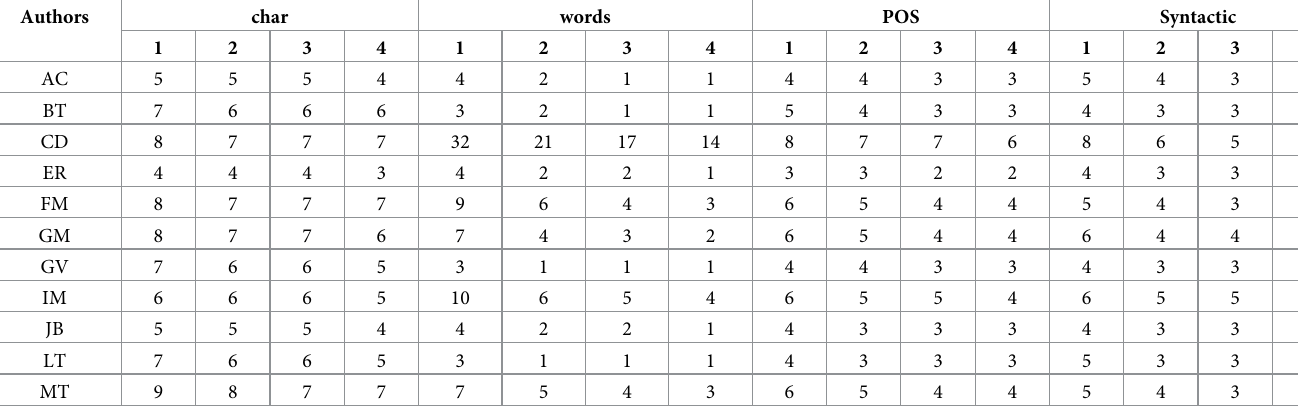
Table 4. Number of 3-grams per author (in thousands).